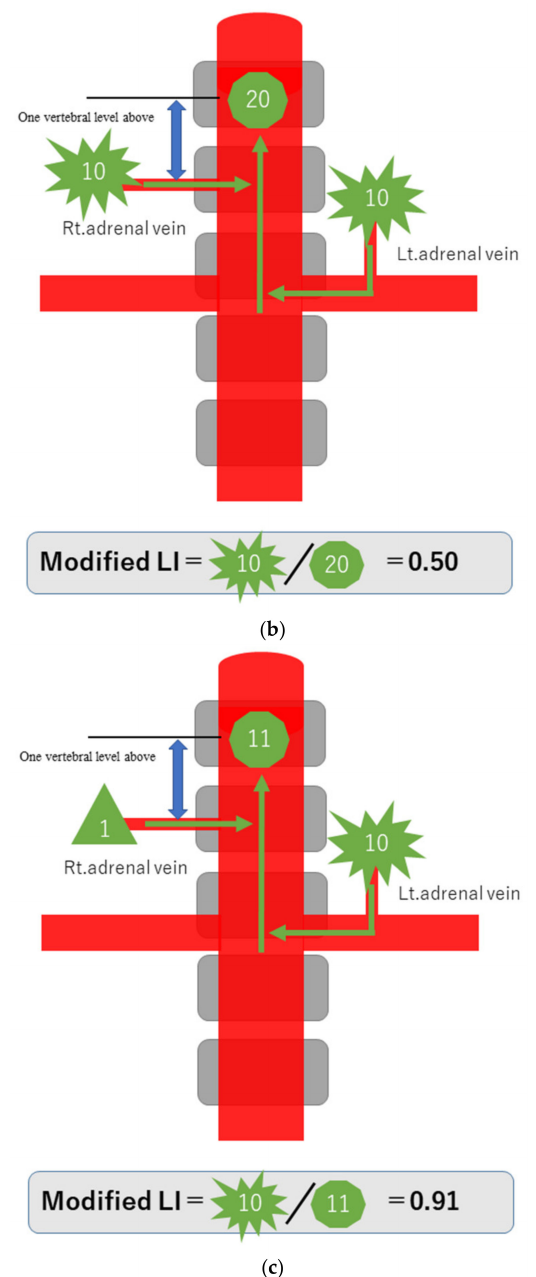
Figure 2. Schematic diagram in case of hormone-producing lesion in the right adrenal gland ( a ), hormone-producing lesions in both adrenal glands ( b ) and hormone-producing lesion in the left adrenal gland ( c ). To explain the modified LI in simple terms, assume that a hormone-producing lesion produces 10 units of hormones, and a normal adrenal gland produces 1 unit. Taking no account of hormone dilution. In case of ( a ), total of 11 units of hormone will be detected in the blood sampled from the S-rt. AdV by the 10 units of oversecreted by the lesion in right adrenal gland and the 1 unit secreted normal left adrenal gland. In case of ( b ), total of 20 units of hormone will be detected in the blood sampled from the S-rt. AdV by the 10 unit oversecreted by the lesion in both adrenal glands. In case of ( c ), total of 11 units of hormone will be detected in the blood sampled from the S-rt. AdV by the one unit secreted normal left adrenal gland and the 10 units of oversecreted by the lesion in right adrenal gland. Substituting these values into the formula for calculating the modified LI, in case of ( a ) (Rt. UAPA), the modified LI = 1/11 = 0.1, in case of ( b ) (IHA), the modified LI = 10/20 = 0.5 and in case of ( c ) (Lt. UAPA), the modified LI = 10/11 =